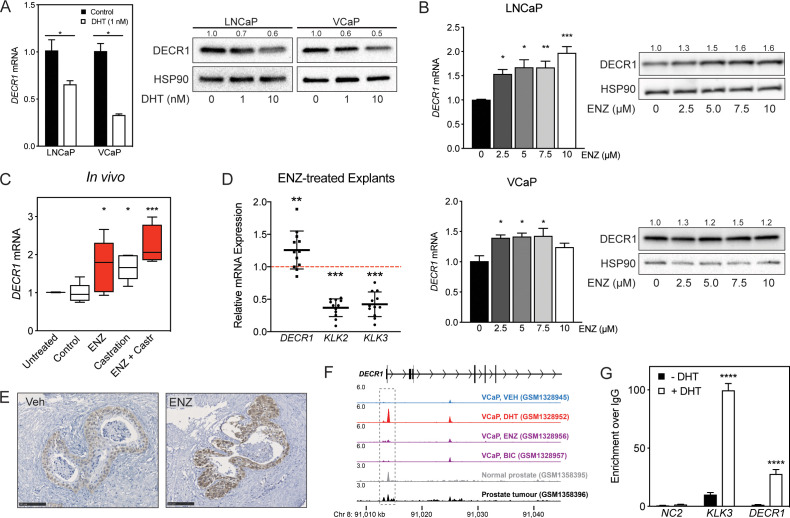
DECR1 is an androgen-repressed gene.(A) DECR1 mRNA and protein was measured by qRT-PCR and western blot analysis after PCa cell treatment with dihydrotestosterone (DHT), or (B) enzalutamide (ENZ). Relative mRNA expression of DECR1 was calculated using comparative CT method, where the cells treated with vehicle (control) were set to one and normalised to the geometric mean CT value of GUSB and L19 (housekeeping genes). Densitometry quantification of relative DECR1 protein expression was normalized to the HSP90 internal control. n = 3 independent experiments. (C) qRT-PCR analysis of DECR1 mRNA expression in LNCaP-derived tumors treated with enzalutamide (ENZ) and/or castration (Castr). (D) qRT-PCR analysis of DECR1 and androgen regulated genes KLK2 and KLK3 mRNA expression in a cohort of 10 patient-derived human prostatic ex vivo tumor explants treated with enzalutamide (ENZ, 10 µM). Relative mRNA expression was calculated using comparative CT method, where the matched untreated tissue from the same patient was set to one and normalized to the geometric mean CT value of TUBA1B, PPIA and GAPDH. (E) Representative DECR1 IHC staining of patient-derived human prostatic ex vivo tumor explants treated with enzalutamide (ENZ, 10 µM). Scale bar, 100 µm. (F) AR ChIP-sequencing data from VCaP cells (top panel), normal human prostate and primary human prostate tumor specimens (bottom panel). Data from GSE55064 and GSE56288. (G) ChIP-qPCR analysis demonstrates AR binding at DECR1 locus in LNCaP cells after treatment with DHT. Data in bar graphs (A, B and G) are represented as the mean ± s.e.m. Data in (C) are represented as box plots using the Tukey method in GraphPad prism. Statistical analysis was performed using two-tailed Student’s t-test (A, C, D and G) or one-way ANOVA, followed by Dunnett's multiple comparisons test (B): *p<0.05, **p<0.01, ***p<0.001 and ****p<0.0001.